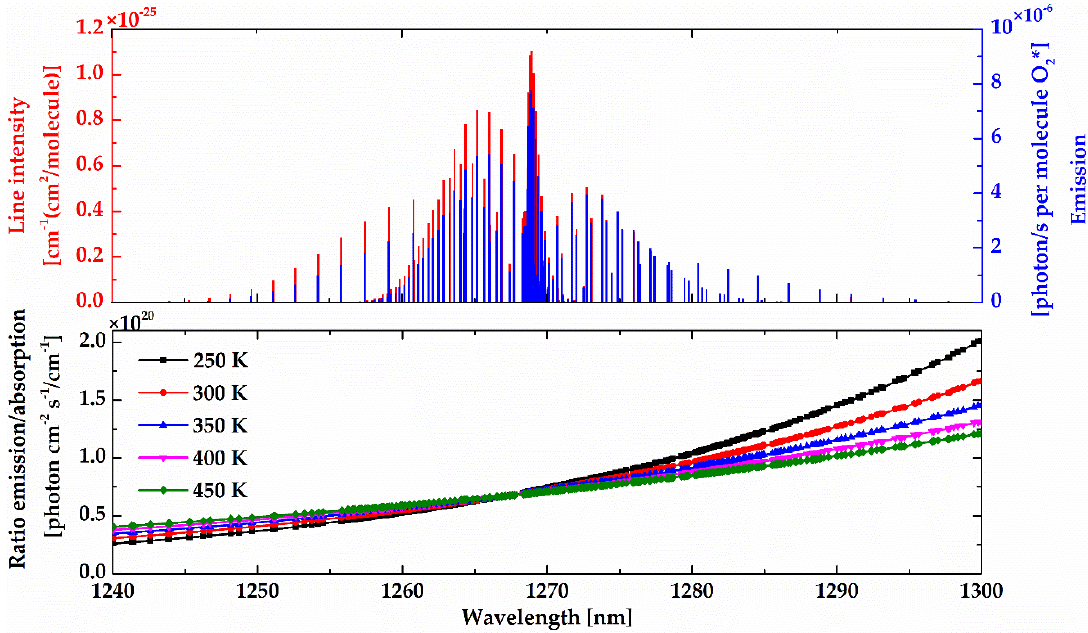
Figure 6. ( a ) The emission and absorption spectrum as a function of the transition wavelength. ( b ) The ratio of emission to absorption line strength for each line.